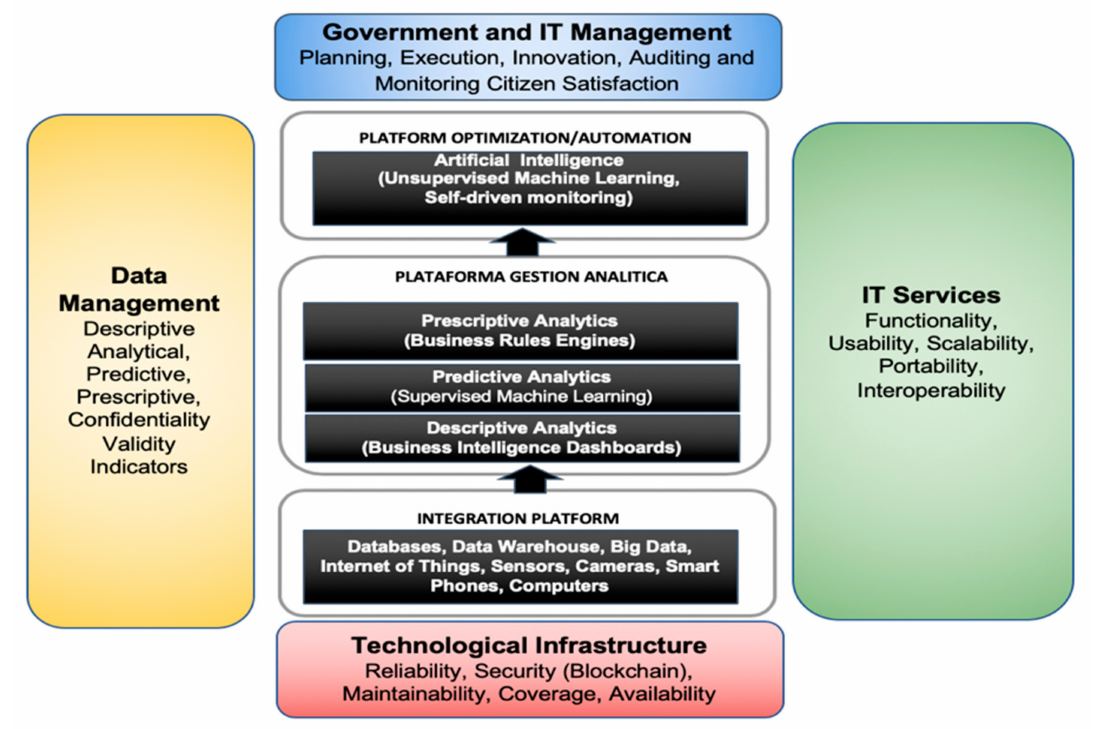
Figure 3. Information